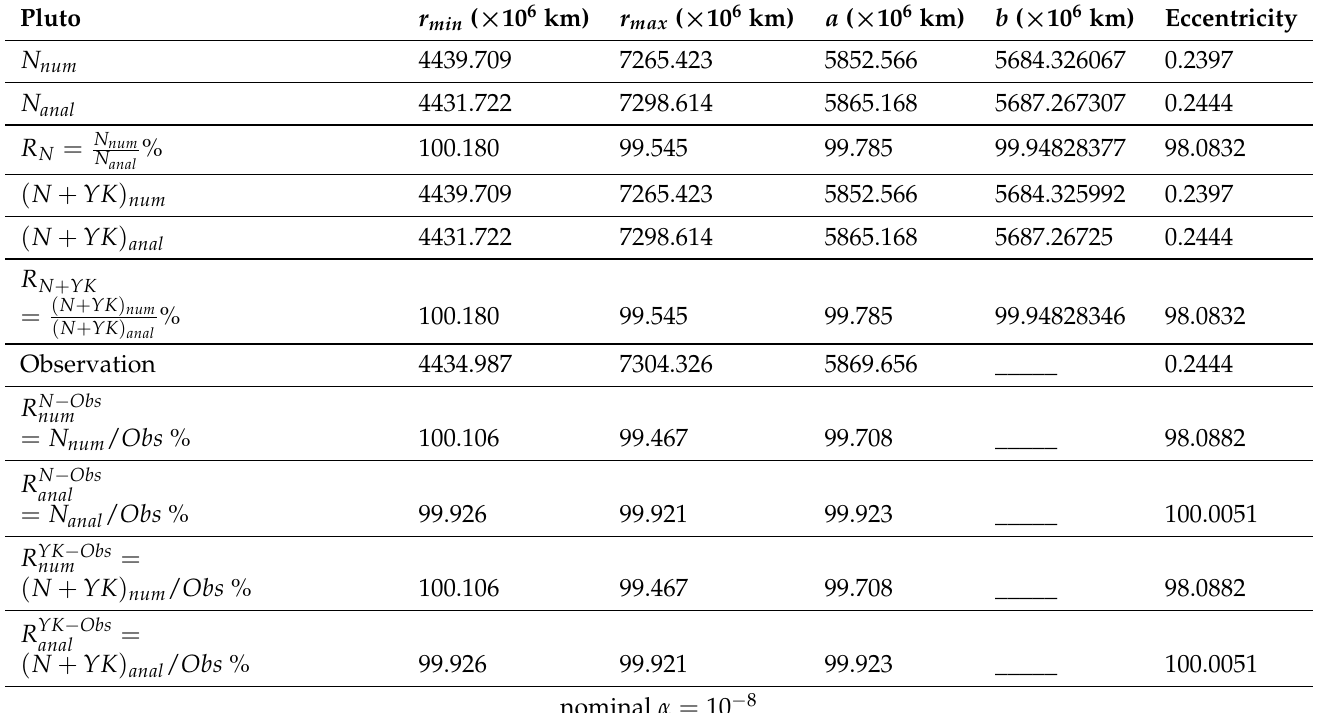
Table A17. The values of the calculated and observational astronomical parameters, for nominal α , of the planet Pluto, whose number of moons is